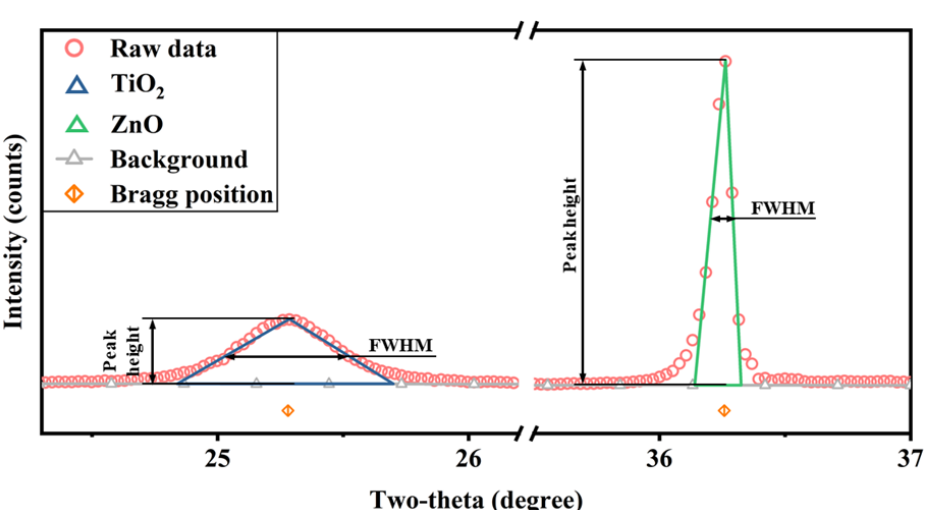
Figure 6. Approximate model of diffraction peak, in which the integral area is approximately FWHM multiplied by the peak height.